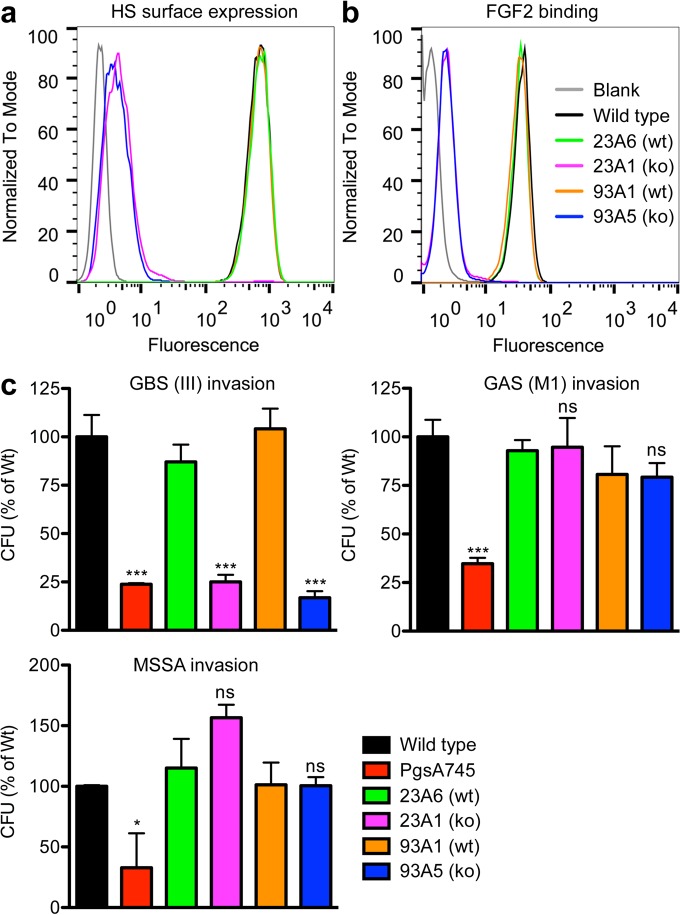
Resistance of pgsA745 cells to GAS and MSSA invasion does not correlate with lack of heparan sulfate expression. (a) Cell surface expression of heparan sulfate was reduced in Xylt2 knockout clonal lines 23A1 and 93A5 generated by CRISPR-cas9 targeting, as measured by flow cytometry using scFv antibody HS4C3. (b) Binding of biotinylated FGF2 to cell surface heparan sulfate was affected similarly in the mutants. (c) Invasion by GBS was reduced in pgsA745 cells and Xylt knockout clonal lines 23A1 and 93A5. In contrast, GAS and MSSA invasion was altered in pgsA745 cells but normal in 23A1 and 93A5 cells compared to the levels of invasion in control clones 23A6 and 93A1. *, P < 0.05, ***, P < 0.001, and ns, not significant versus results for wild-type cells using the two-tailed t test. Error bars indicate standard deviations (SD); n = 3.